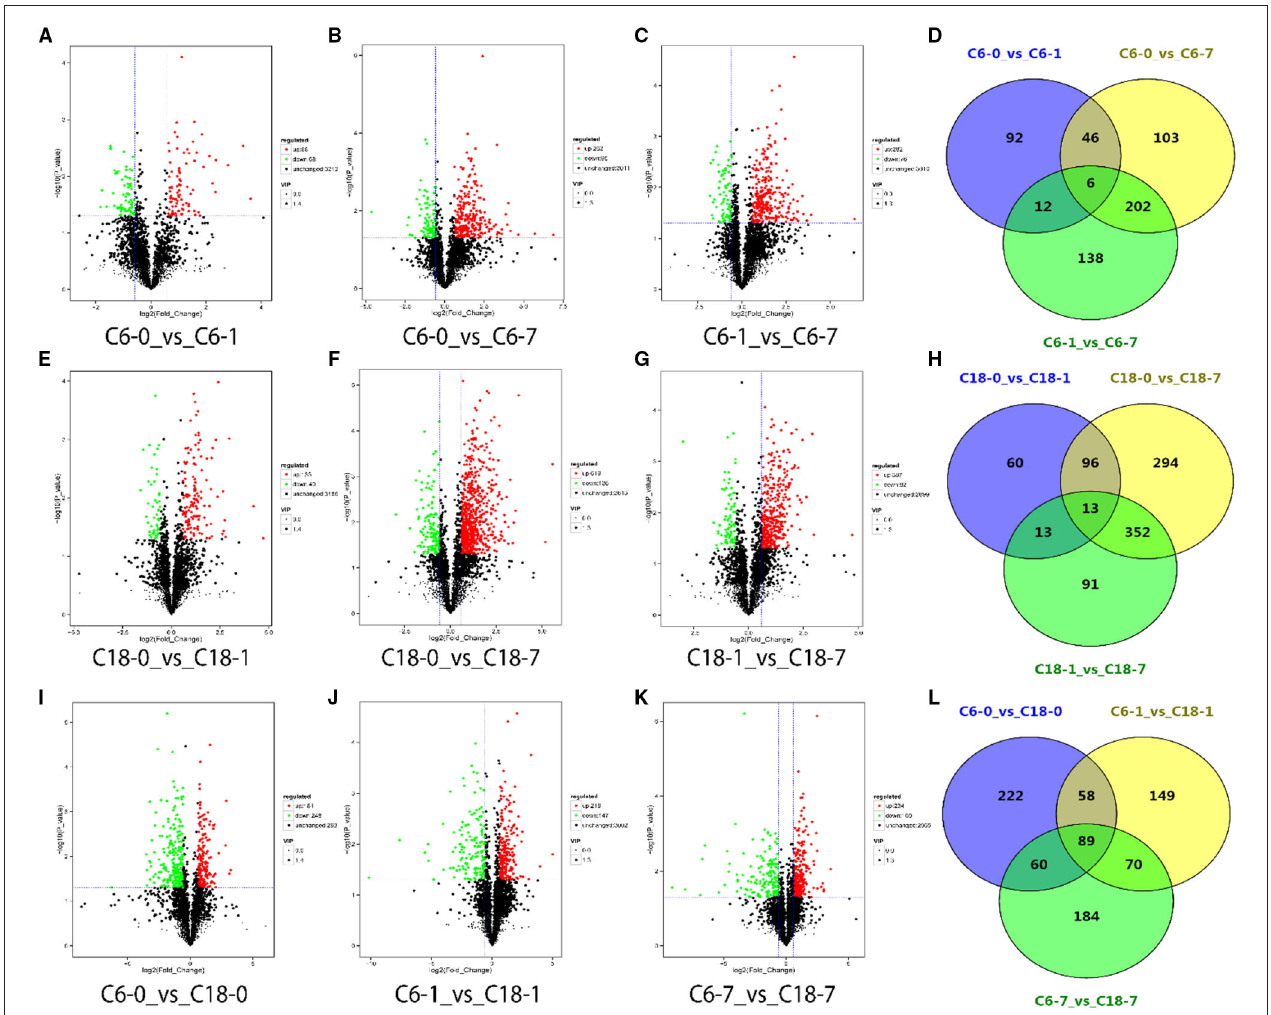
FIGURE 2 | Volcano plots for differentially accumulated metabolites (DAMs) with the comparison of control with their time points. (A–C) DAMs from the cold-sensitive (C6) variety; (E–G) DAMs from the cold-tolerant (C18) variety; (I–K) DAMs between C6 and C18 at the same time points. Venn diagrams showing the shared and common DAMs for all time points (D) between the different time points in C6; (H) between the different time points in C18; (L) between the same time points in C6 and